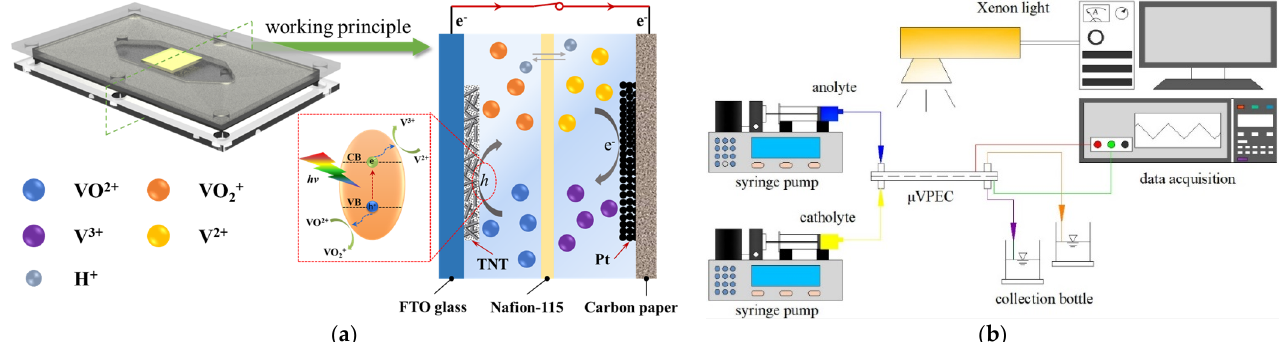
Figure 1. Schematic illustration of ( a ) the microfluidic all-vanadium photoelectrochemical cell and ( b ) the experimental system.